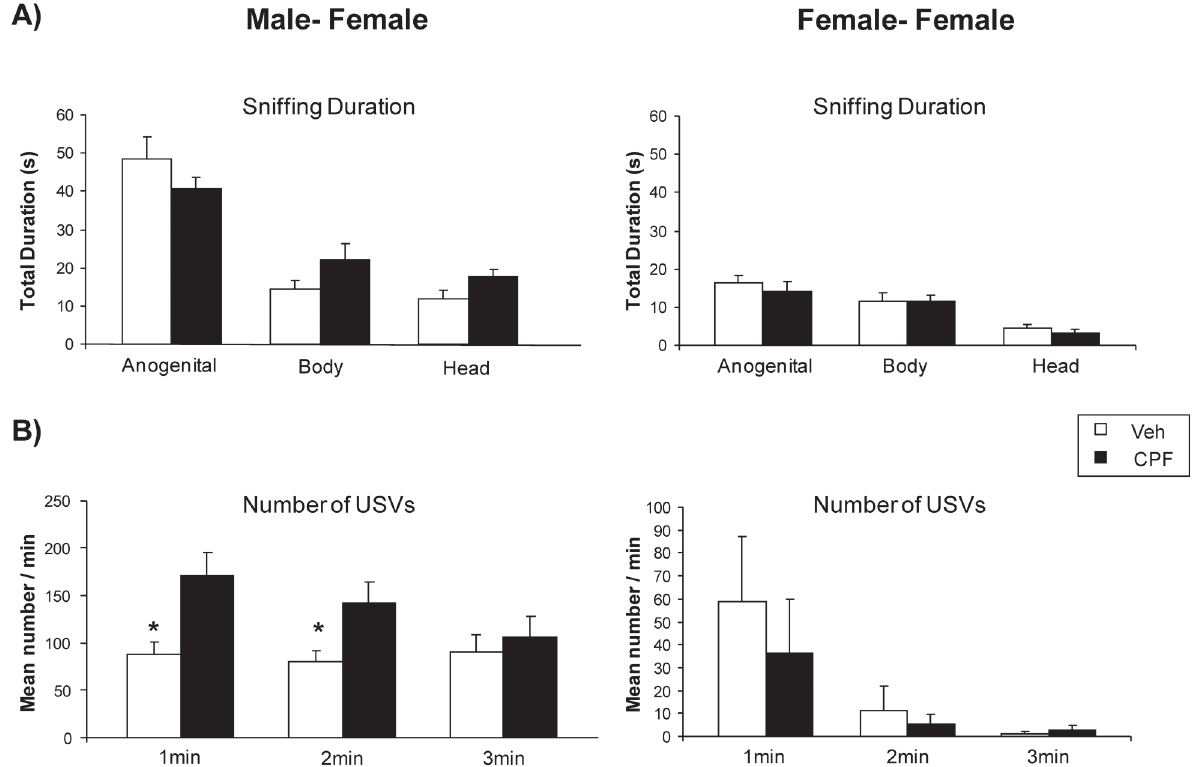
Fig 5. Adult social interaction shown by CPF- and Veh-treated mice of both sexes at adulthood. Left panel — Male- Female social interaction: A) Sniffing duration, B) number of USVs emitted during 3-min of direct interaction between male and a sexually-receptive female. Right panel — Female-Female social interaction: A) Sniffing duration, B) number of ultrasonic vocalizations emitted during 3-min of direct interaction between a resident and intruder female. Anogenital, Body and Head refer to the areas of the social partner's body investigated by the experimental subject. Data are expressed as mean ± SEM. * p < 0.05 after post hoc comparisons. Females: Veh, n = 11; CPF, n = 10; Males: Veh, n = 9, CPF, n = 9.